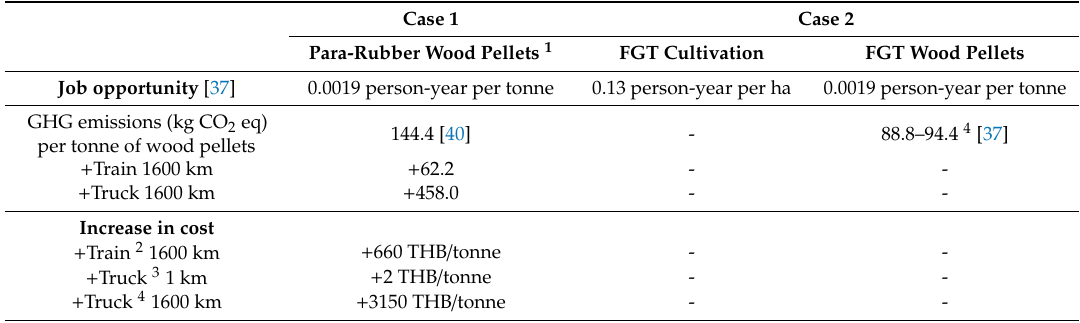
Table 10. Comparison of Cases 1 and 2 in terms of job opportunity, GHG emissions and increase in